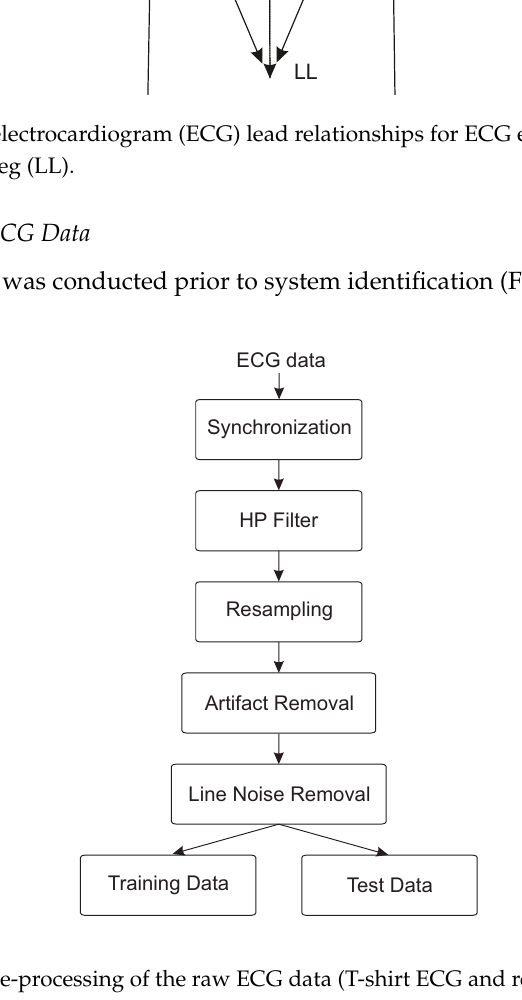
Figure 2. Pre-processing of the raw ECG data (T-shirt ECG and reference